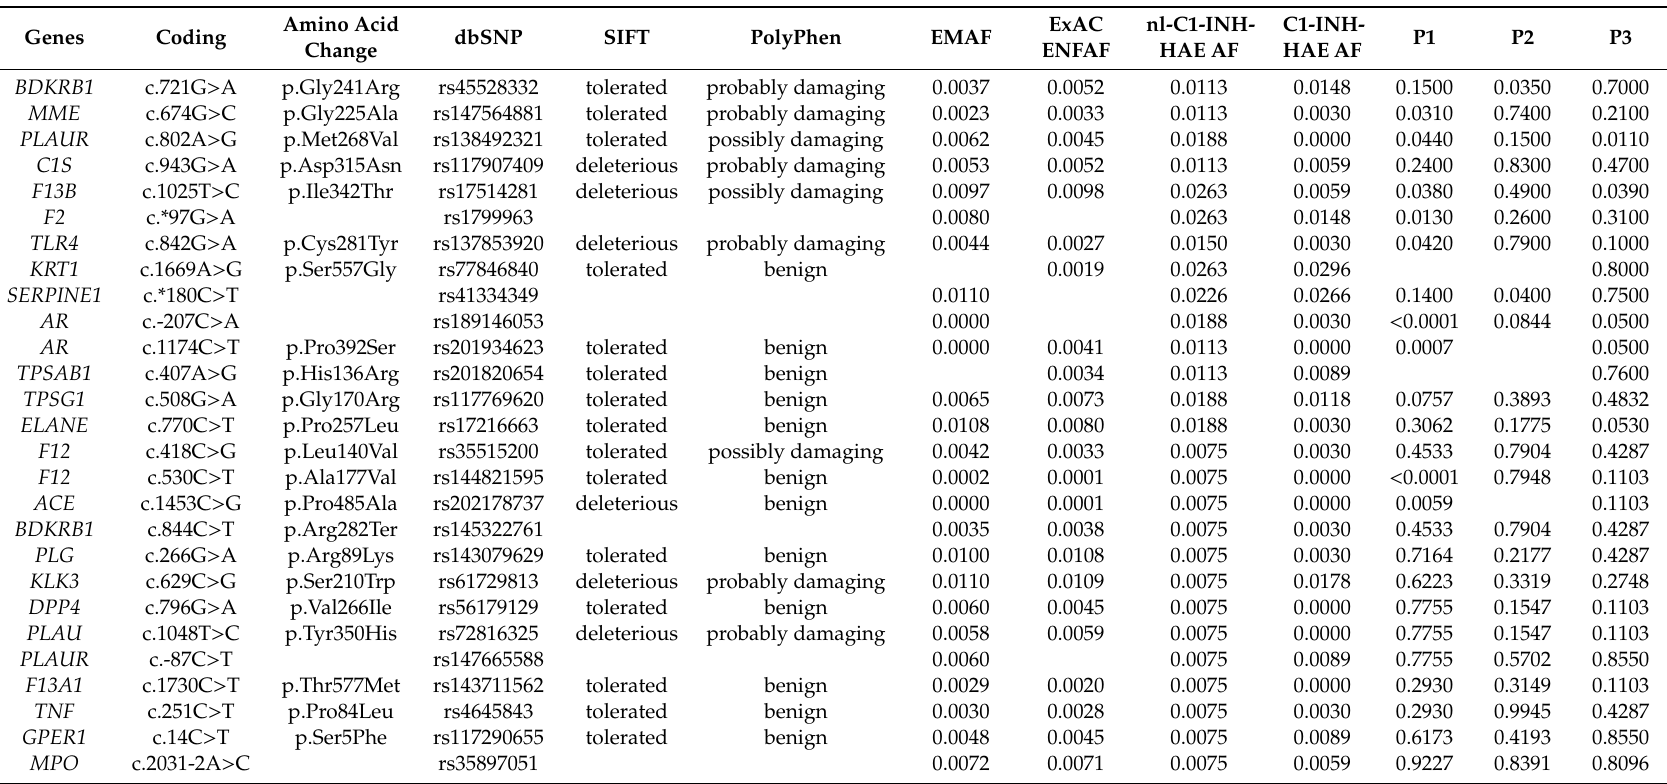
Table 1. Variants with a worldwide allelic frequency of < 1% that were detected in our material more than once. EMAF: European minor allele frequency; ExAC ENFAF: ExAC European non-Finnish allele frequency; nl-C1-INH-HAE AF: allele frequency among nl-C1-INH-HAE patients; C1-INH-HAE AF: allele frequency among C1-INH-HAE patients, P1: EMAF vs. nl-C1-INH-HAE AF, P2: EMAF vs. C1-INH-HAE AF, P3: ni-C1-INH-HAE AF vs. C1-INH-HAE